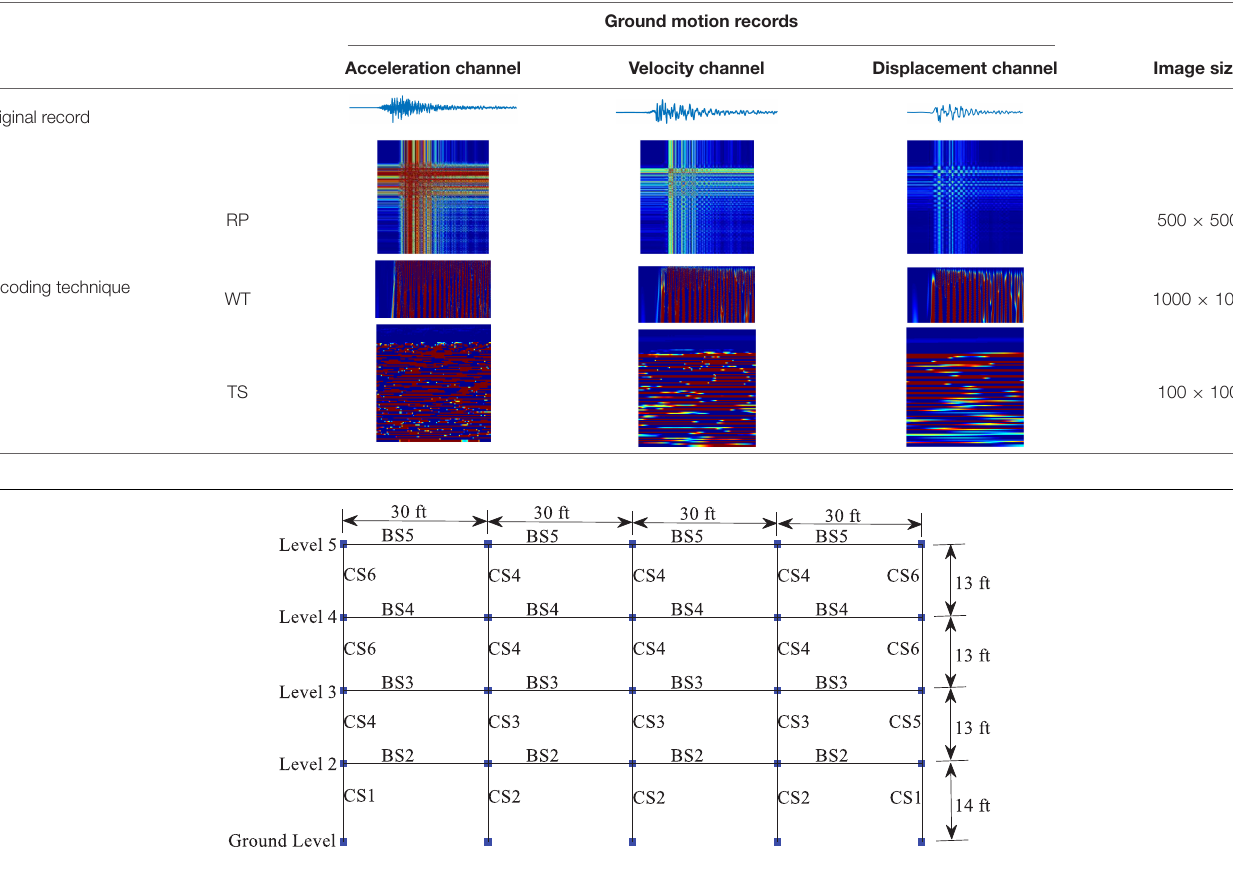
FIGURE 3 | The elevation view of the benchmark structure (1 ft = 3.3